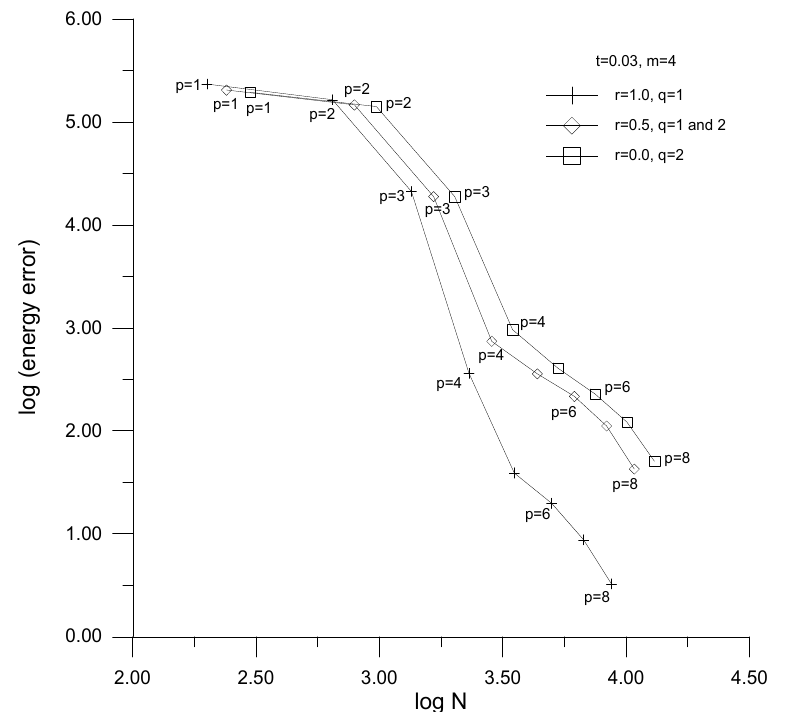
Figure 24. Convergence curves—the bending-dominated shell with the modified transition